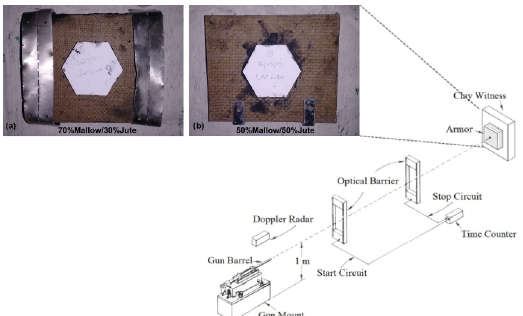
Figure 3. Schematic arrangement of the ballistic test. Insert of actual MAS with front hexagonal ceramic followed by hybrid (a) 70 mallow / 30 jute; (b) 50 mallow / 50 jute fabric composite and backed by aluminum sheet in direct contact with clay witness. In this figure, the MAS target was positioned by spring clamps to a steel frame. The center of the MAS target was sighted with a laser beam coupled to the gun barrel at a